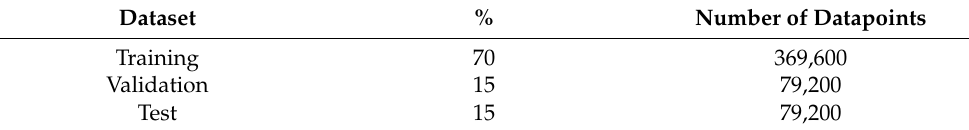
Table 3. Number of datapoints of the WASI-generated simulation dataset for each of the three subsets.